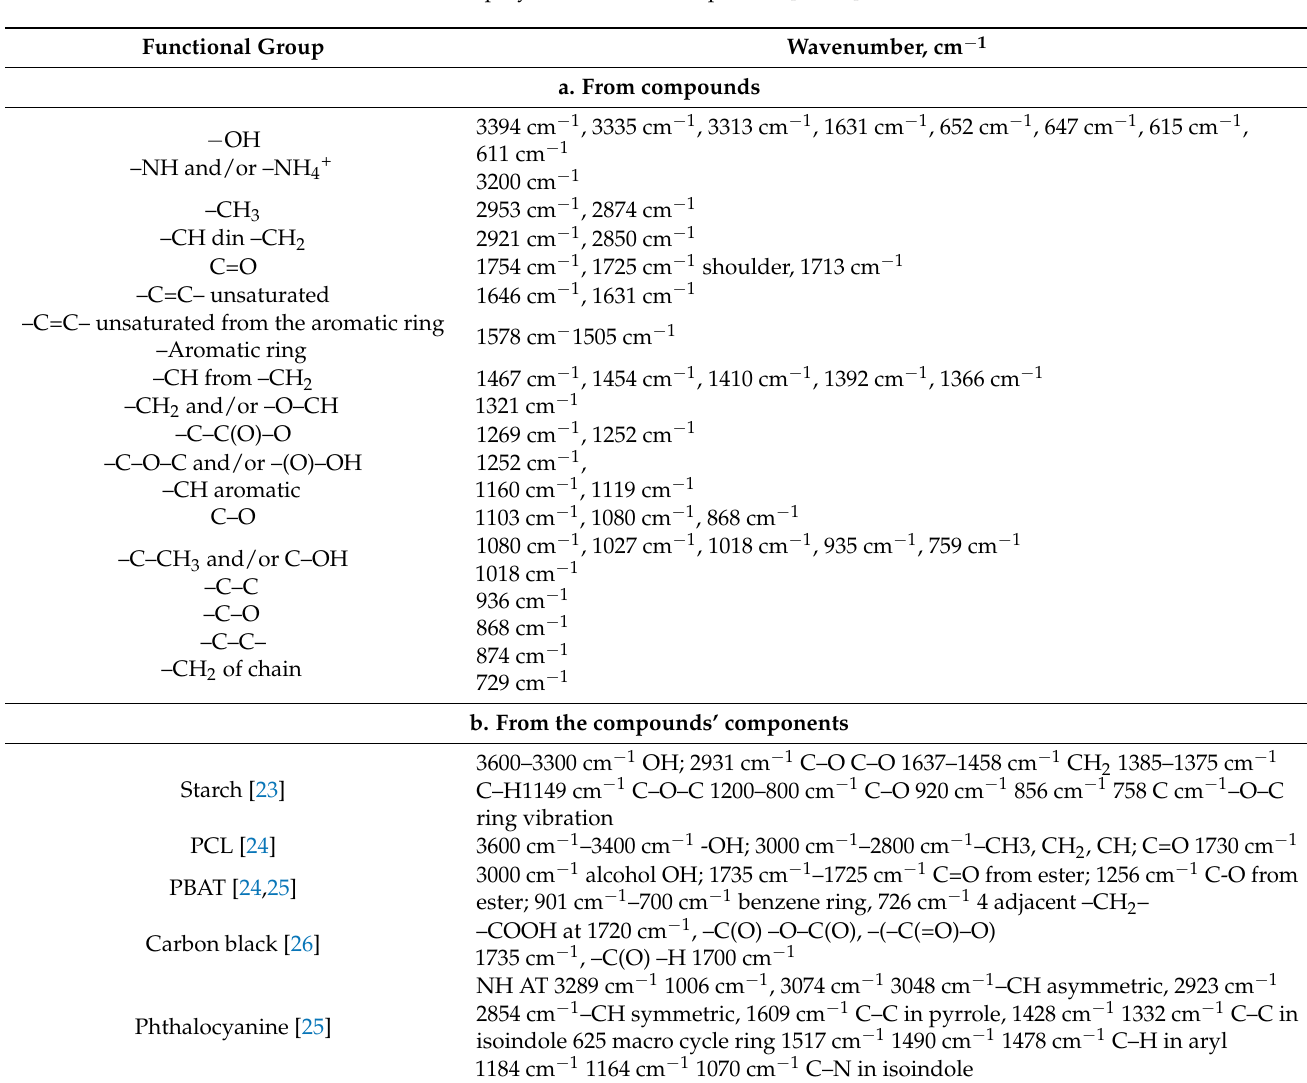
Table 11. Wavelengths of FTIR peaks of the analyzed compounds, their assignments, and those of the constituent polymers of these compounds